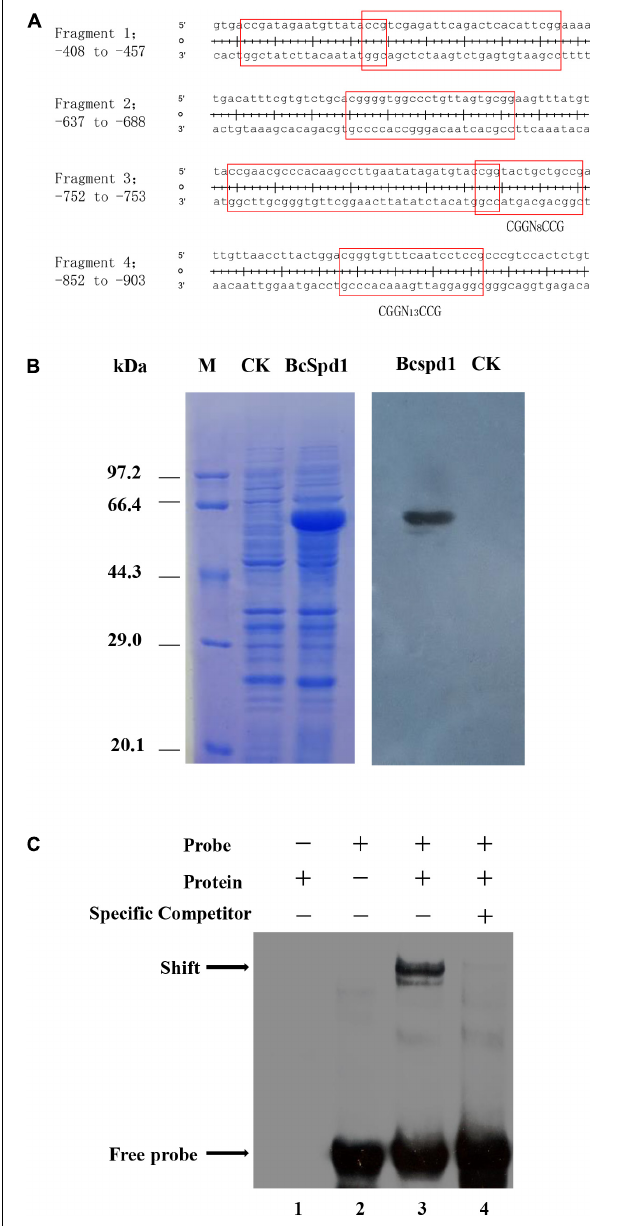
FIGURE 6 | BcSpd1 regulates BcQdo -mediated B. cinerea virulence. (A) Conserved DNA fragments in the promoter of BcQdo . The predicted transcription factor-binding sites were framed. (B) SDS-PAGE and Western blot analysis of recombinant BcSpd1 in Escherichia coli . Left: The proteins were stained with Coomassie brilliant blue R-250. M, Positions of marker proteins. CK, SDS-PAGE of the extracts from empty pET28a-transformed bacterial cultures. BcSpd1, SDS-PAGE of the recombinant BcSpd1 extracted from pET28a -BcSpd1 -transformed bacterial culture. Right: Western blot analysis of BcSpd1 protein in the indicated bacterial cultures (anti-His). (C) EMSA analysis of BcSpd1 binding to biotin-labeled promoter fragments of BcQdo . Line 1, the reaction only with recombinant BcSpd1 protein; line 2, the reaction with only biotin-labeled probes; line 3, the reaction with both recombinant BcSpd1 protein and biotin-labeled probes, which showed binding shift; line 4, the unlabeled probes were added to the reaction and competed the